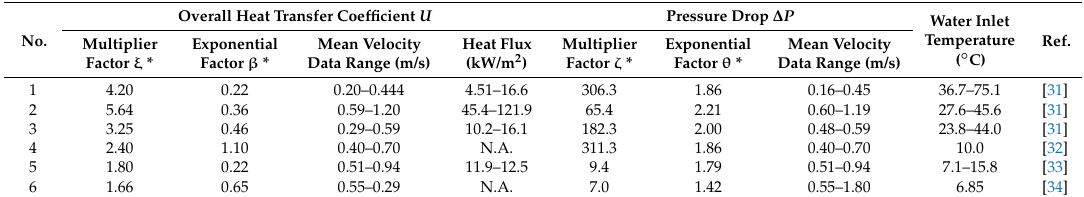
Table 2. Approximation coefficients.